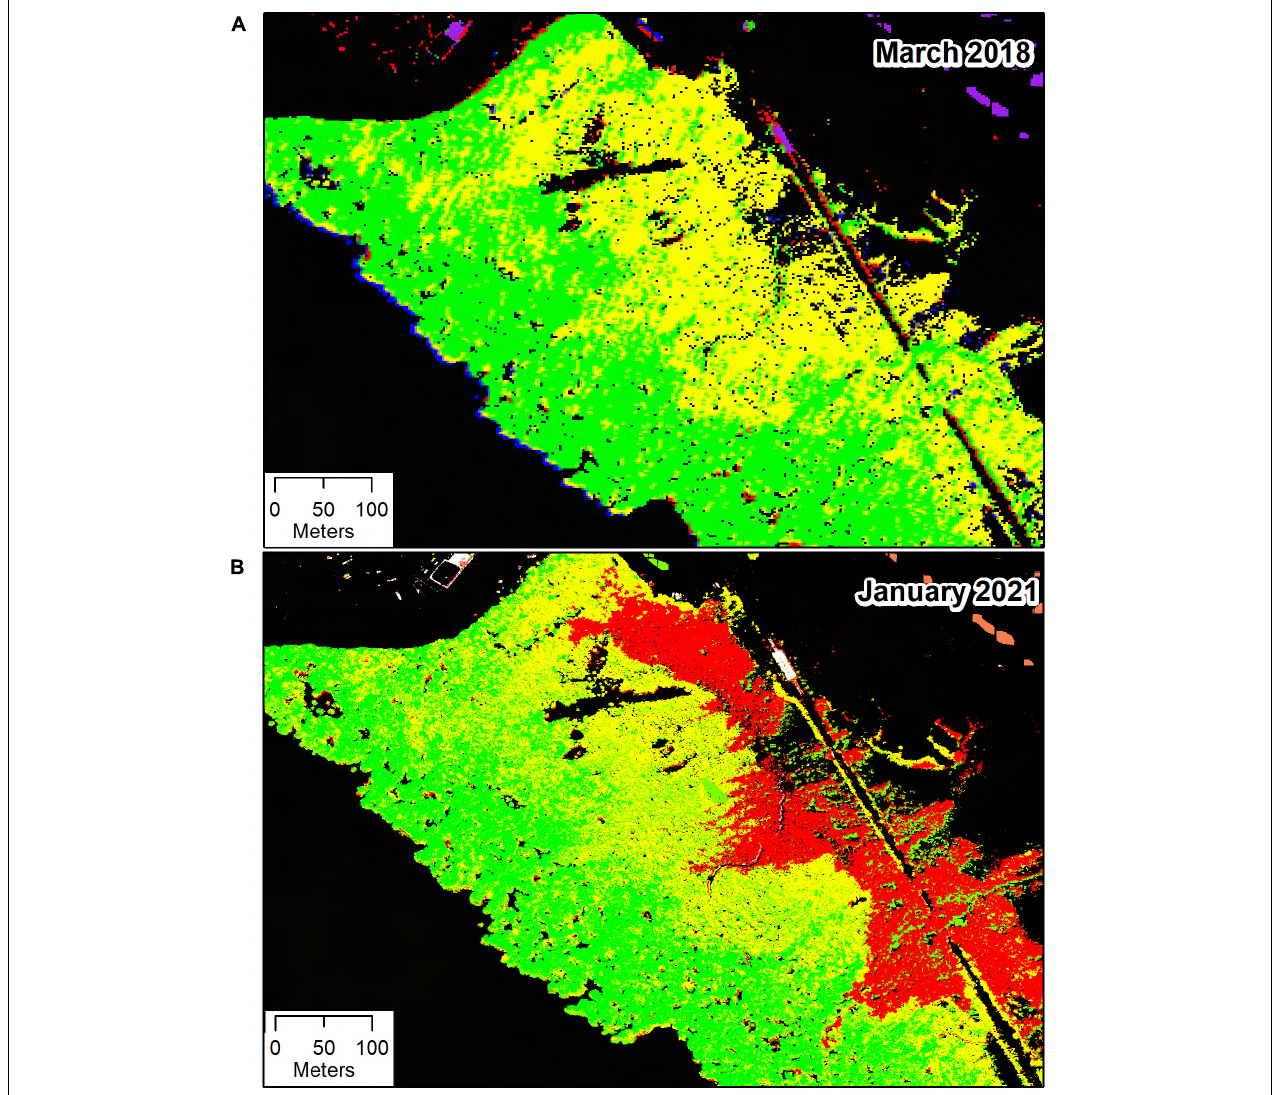
FIGURE 2 | Hyperspectral images from the temperate mangrove forest (saltmarsh and other vegetation was masked out) near St Kilda, South Australia, from March 2018 (A) and January 2021 (B) . Mangroves were classified as “healthy” (green), “stressed” (yellow), and “dead” (red).